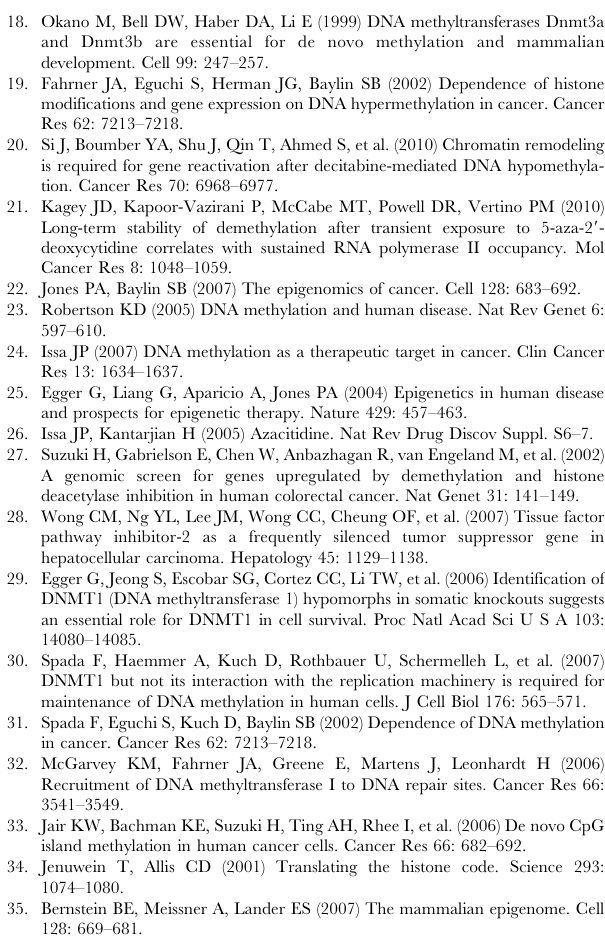
Figure S1 Position of primers used in expression and epigenetic studies. Positions indicated above are reference to the putative DLC1 transcription start site (TSS) according to the Genebank database NM_006094. Figure S2 DLC1 methylation in normal liver cell line (MIHA) and liver cancer cell line (SMMC-7721). DNA methylation at + 45 to + 336 position of DLC1 gene was analyzed by bisulfite DNA sequencing. PCR products were cloned into TOPO TA Cloning vector (Invitrogen) and five clones from each sample were sequenced. Open circle: Unmethylated CpG site; Closed circle: methylated CpG dinucleotide. Figure S3 Re-silencing of DLC1 and E-Cadherin in HeLa cell after 5-Aza-dC treatment. HeLa cell was treated with 5 uM 5-Aza-dC for 96 hrs (Day 4) and allowed to recover in drug free culture medium (Day 8 and Day 12). Expression of hypermethylated genes, DLC1 and E-Cadherin were monitored by